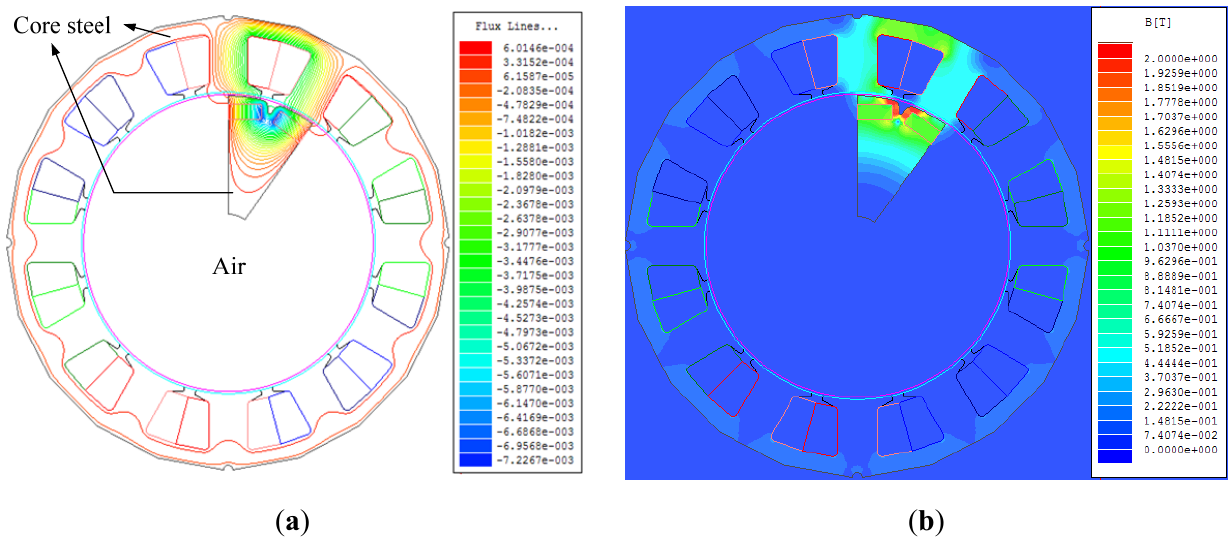
Figure 3. Schematic diagram of magnetic field: ( a ) magnetic field lines; ( b ) flux density.